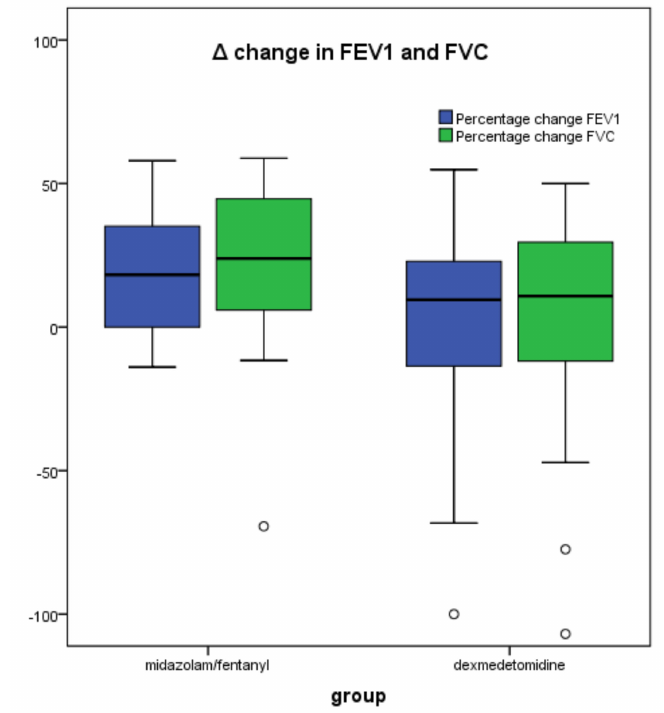
Figure 2. Percentage change in FEV1 and FVC before and after the procedure. The addition of dexmedetomidine to midazolam/fentanyl is associated with less decrease in FEV1 postoperatively. Bars represent means; boxes represent interquartile ranges; error bars represent ranges and dots rep- resent outliers. Abbreviations: FEV1, forced expiratory volume in 1 min; FVC, forced vital capacity.